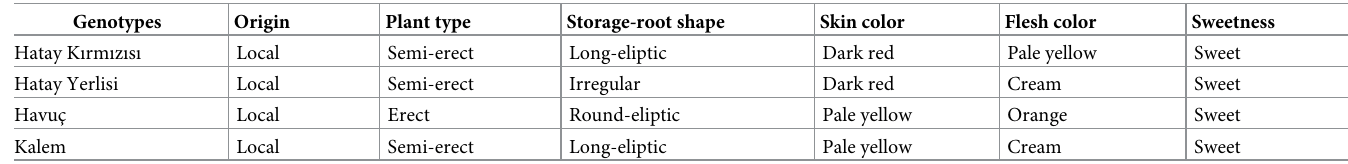
Table 1. Description, origin and some morphological attributes of local sweet potato genotypes included in the study adopted from C¸alı ş kan et al. [6].